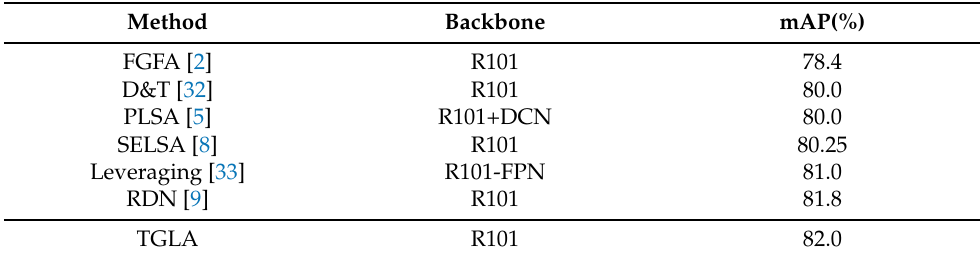
Table 3. Performance comparison with other state-of-the-art models on the ImageNet VID validation set. TGLA is our method with the framework and FIM. Here, R101 is ResNet-101 and DCN is a deformable convolutional network.